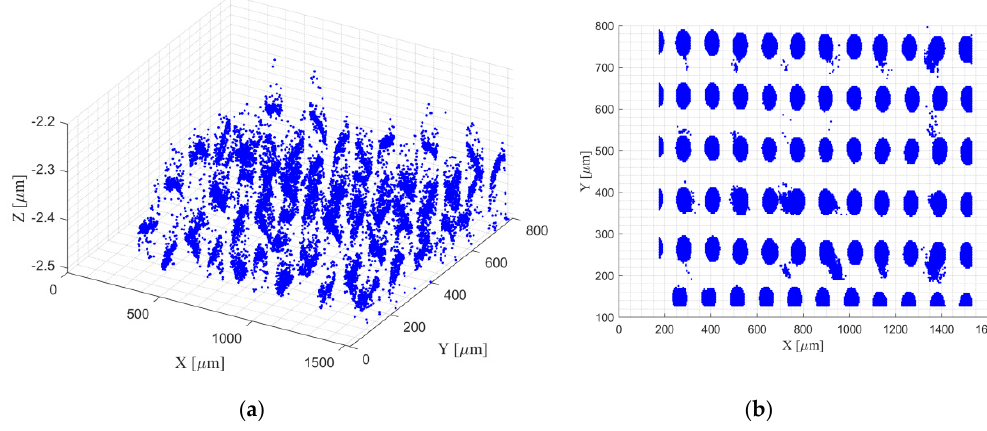
Figure 8. The separated cylinders of the rotated surface: ( a ) 3D view; ( b ) view from top down.